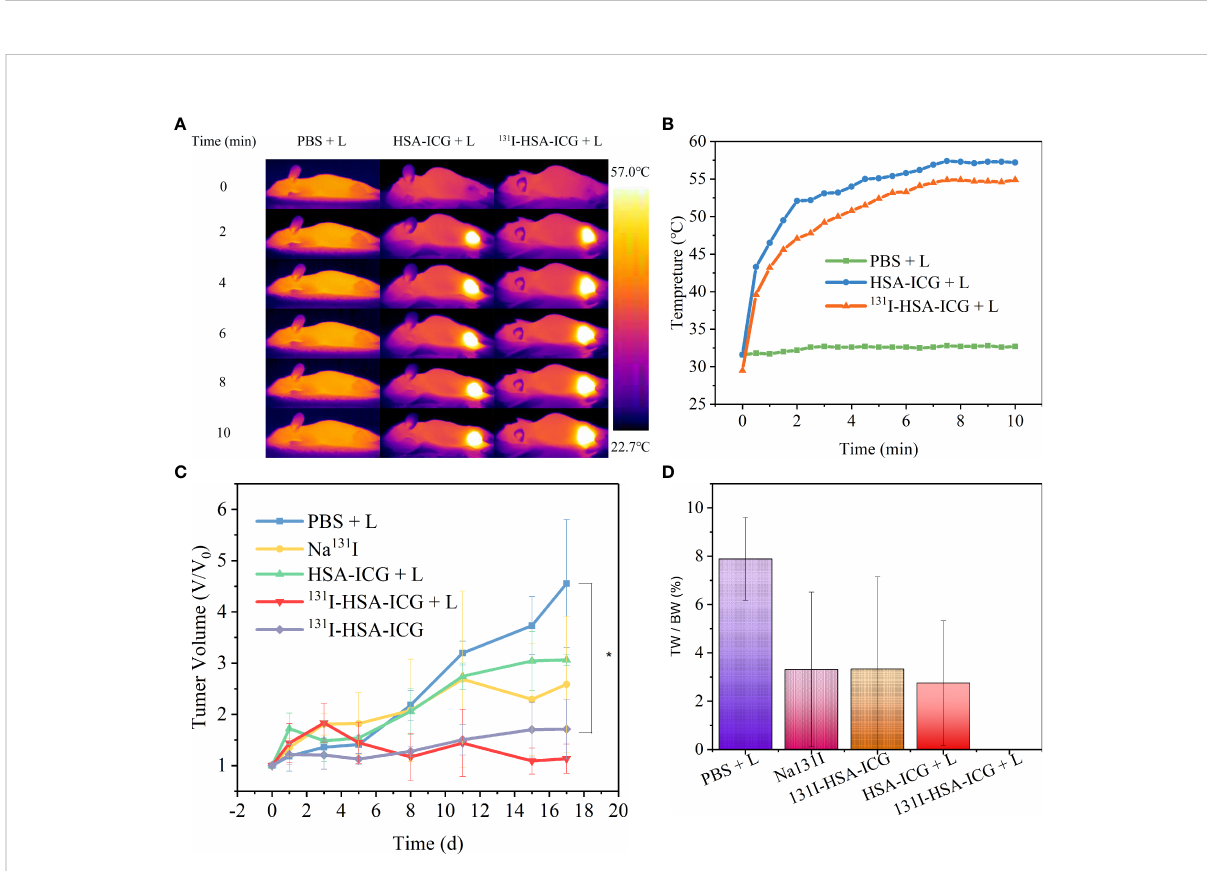
FIGURE 5 (A) Infrared calori fi c value images of tumor surface temperature changes in nude mice during 808-nm laser irradiation (C ICG = 2 mg/kg, 0.5 W/ cm 2 , 5 min). L: 808-nm laser irradiation. (B) The tumor surface temperature change curves of nude mice in each group during 808-nm laser irradiation (C ICG = 2 mg/kg, 0.5 W/cm 2 , 5 min). (C) The trends of tumor volume changes in nude mice in different treatment groups, expressed as mean ± SD; *, p < 0.05. (D) The ratio of tumor weight (TW) to body weight (BW) after 17 days in different treatment groups; *, p < 0.05. ICG, indocyanine green; HSA, human serum albumin; SPECT, single-photon emission